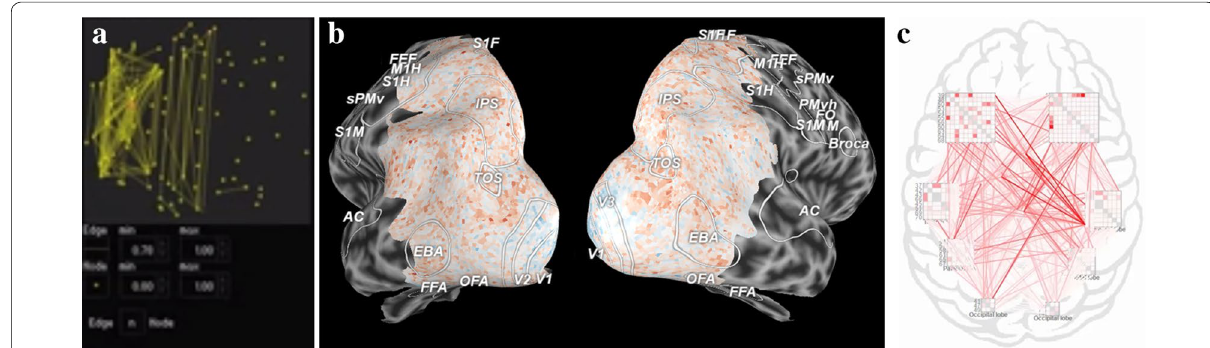
Fig. 9 Example abstract anatomy visualisations; these trade off some of the benefits of the direct anatomical reference for improved representations of the fMRI data: a two-dimensional representation of the ROIs throughout a brain with edges displaying coactivity (from Brain Constellation [85]); b a split and flattened view of the brain surface with a heatmap overlaid (made in PyCortex [86]); c NodeTrix visualisation on a 2D sketch of the brain, showing connections and local neighbourhood information, which may be useful for investigating data